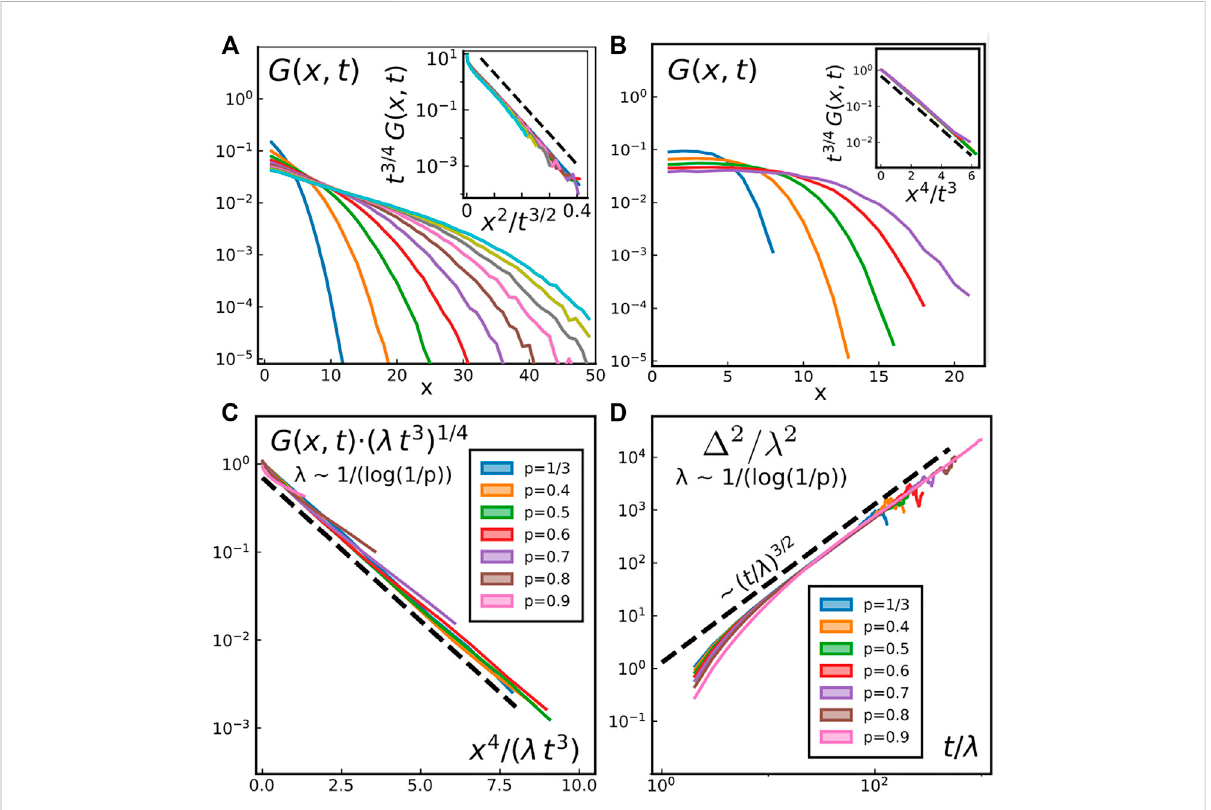
FIGURE 13 Probability densities of displacement G ( x , t ) (see main text for de fi nition) for different cases. Both insets represent rescaled data in order to highlightthefunctionalformof (G) .Weconsidered (A) topologicaldefectswith σ 2 =0.025and T =0.2,attimes(fromlefttoright) t =50,100,150, ...